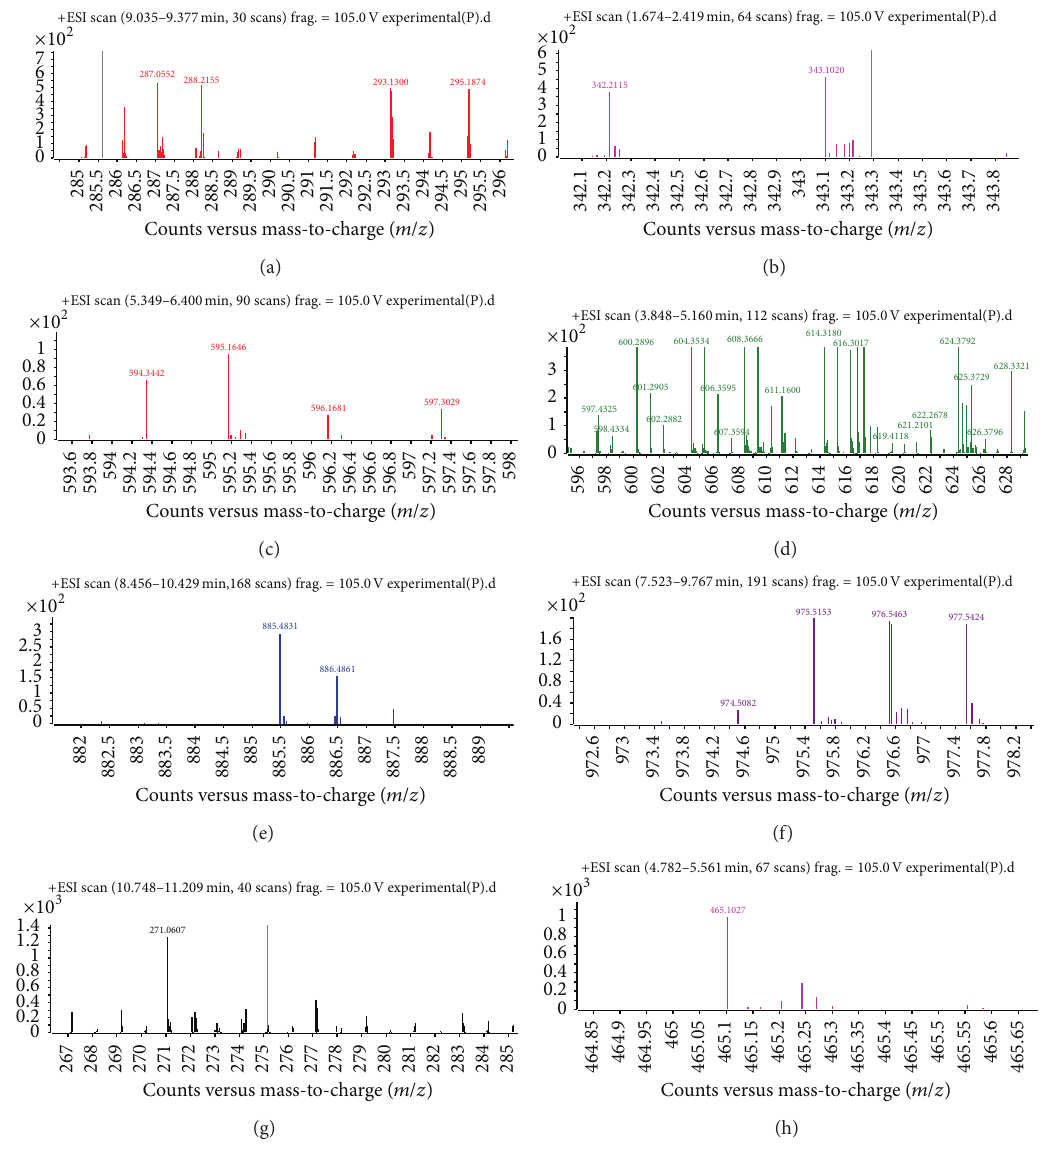
Figure 4: High-resolution MS spectra of the LC-MS peaks that only presented in Sanjin Tablets eluate with molecular ion peaks at mass-to- charge ( 𝑚/𝑧 ) ratios 287.1 ((a) retention time 11.8min), 343.1 ((b) retention time 2.1 min), 595.2 ((c) retention time 3.1 min), 611.1 ((d) retention time 4.5 min), 885.5 ((e) retention time 9.4 min), 975.5 ((f) retention time 8.6 min), 271.1 ((g) retention time 11.0 min), and 465.1 ((h) retention time 5.2